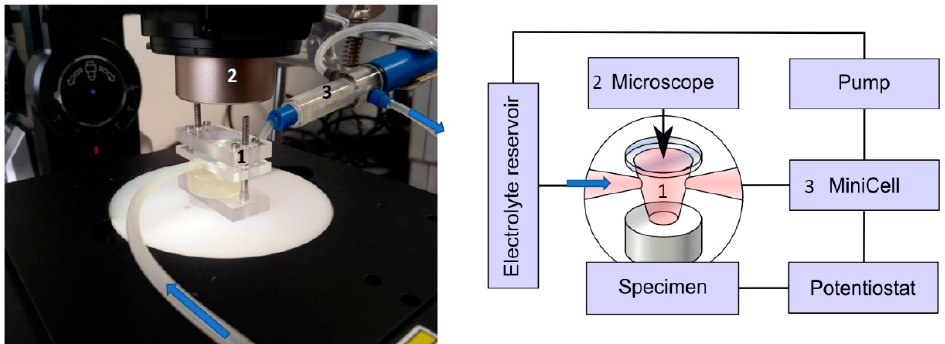
Figure 2. Video-optical-electrochemical cell with mounted specimen, connected to electrolyte inlet and Mini-Cell (background), beneath Keyence optical microscope. At left, a schematic view.